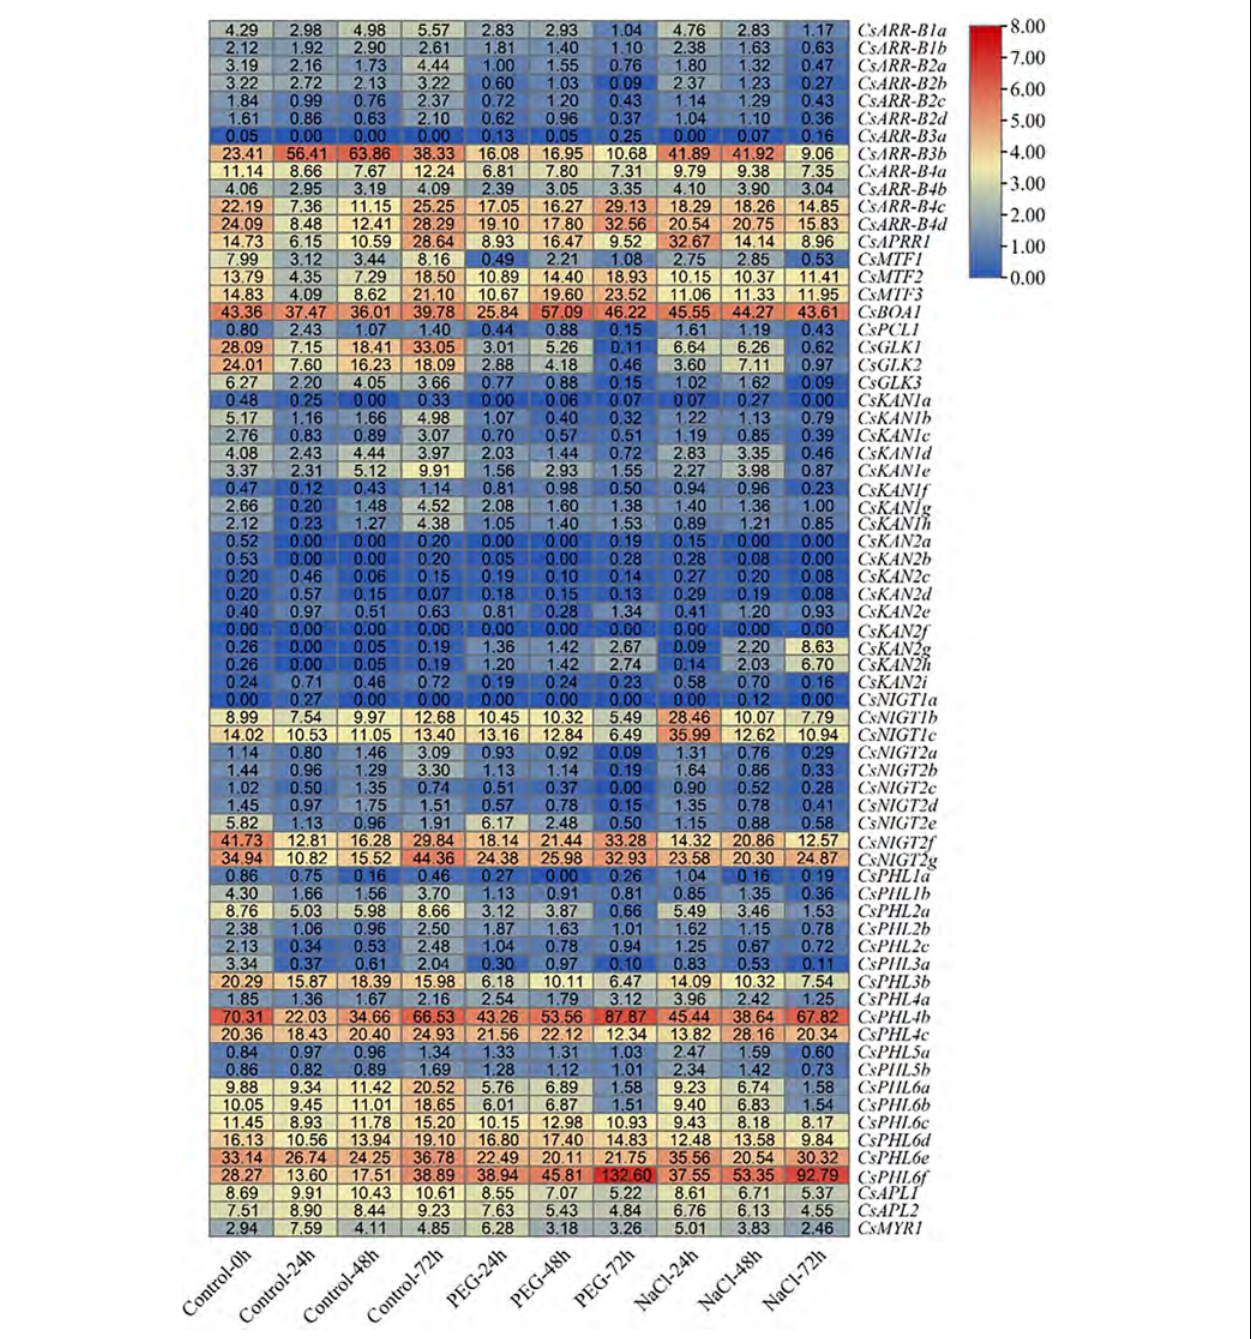
FIGURE 11 | Expression analysis of CsGARPs in response to drought and salt stress treatments. The expression levels of CsGARPs were calculated with TPM values. The red and blue colors represent high and low expression levels, respectively. N: control conditions, PEG-N: drought stress imposed via 25% polyethylene glycol (PEG)6000, NaCl-N: salt stress imposed via 200 mM